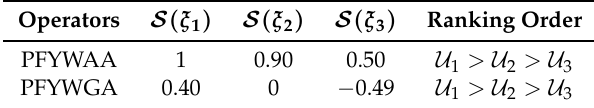
Table 4. Comparison analysis of PFYWAA and PFYWGA operators.